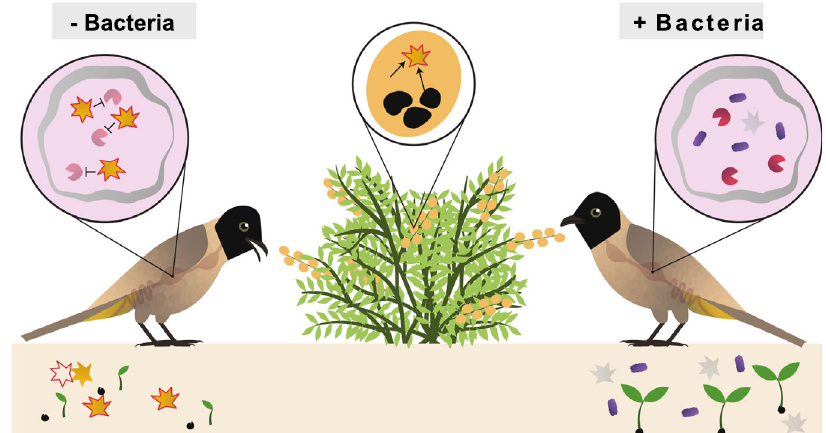
Fig. 6 | The effect of the “ Ochradenus baccatus -oil-bomb ” on the bird and on seedling growth in the presence of Pantoea 45 bacterial isolate. A schematic modeldescribing the multitrophicinteractionmediated by the bacteria,positively affecting bothplantsand birds. Aftermixing of O.baccatus pulpand seeds, the “ O. baccatus- oil-bomb ” is activated and BenzylGSL is created (star) in the bird ’ s digestive system, leading to the inhibition of digestive enzyme activity (purple